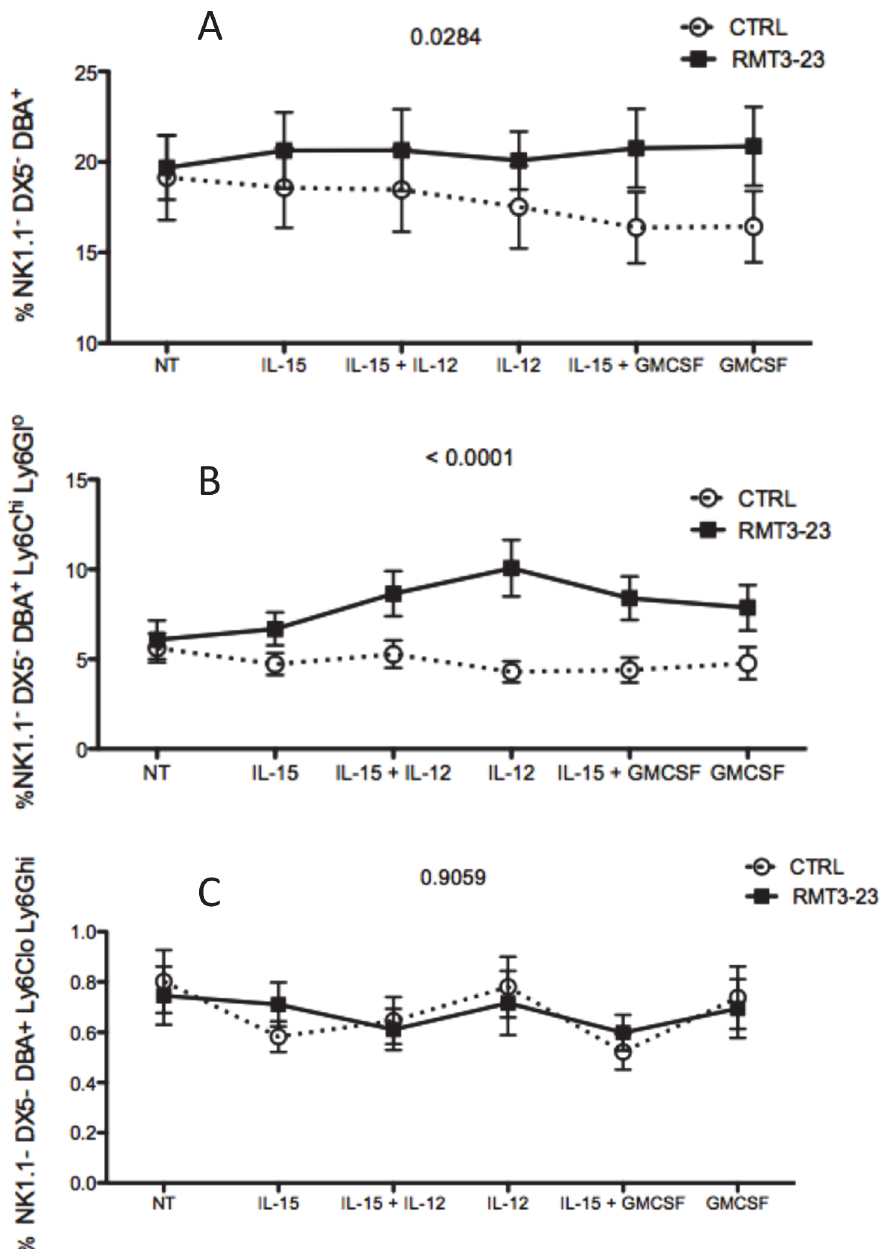
Fig 9. Effect of GM-CSF and IL-15 on the uNK cells from pregnant CBA mice. CBA/CaJ female mice were mated with C57BL/6 allogeneic male mice. Uterine lymphocytes were isolated from Control and RMT3- 23 treated mice and cultured with IL-15, IL-15+IL-12, IL-12, IL-15+GMCSF and GMCSF only for 7days in vitro in a 37°C humidified CO2 incubator. At the end of the incubation period the percentage of 3 different cell populations were determined by flow cytometry. A. RMT3-23 treated uNK cells proliferated more in response to IL-12 (p = 0.0284). B. This effect was more pronounced in the uNK cells expressing the MDSC markers (p <